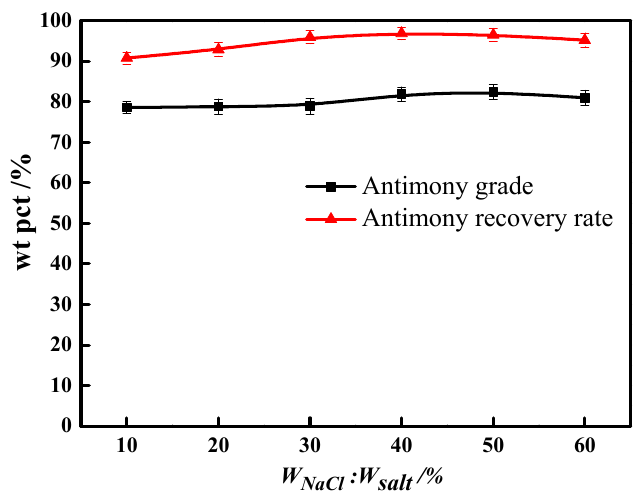
Figure 5. Influence of molten salt composition on the extraction of antimony and crude antimony